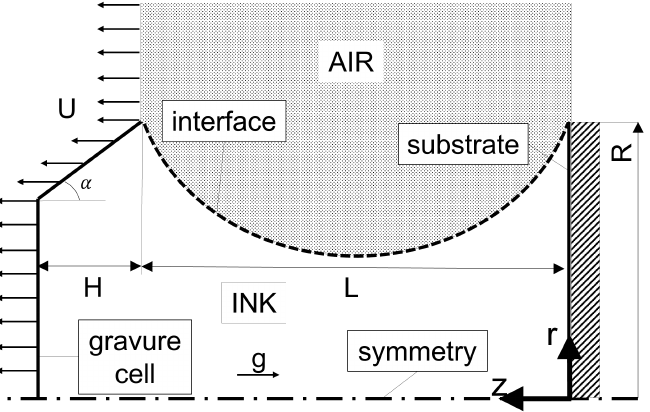
Figure 2. Sketch of the domain employed for the gravure cell printing process. The main dimensional parameters are: R = 2.5 mm, H = 1 mm, α = 15 ◦ , and L 0 ≤ L ≤ L b , where L 0 = 0.75 mm and L b is the breakup